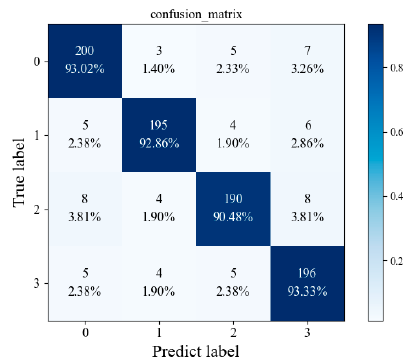
Figure 18. DenseNet121 classification model.